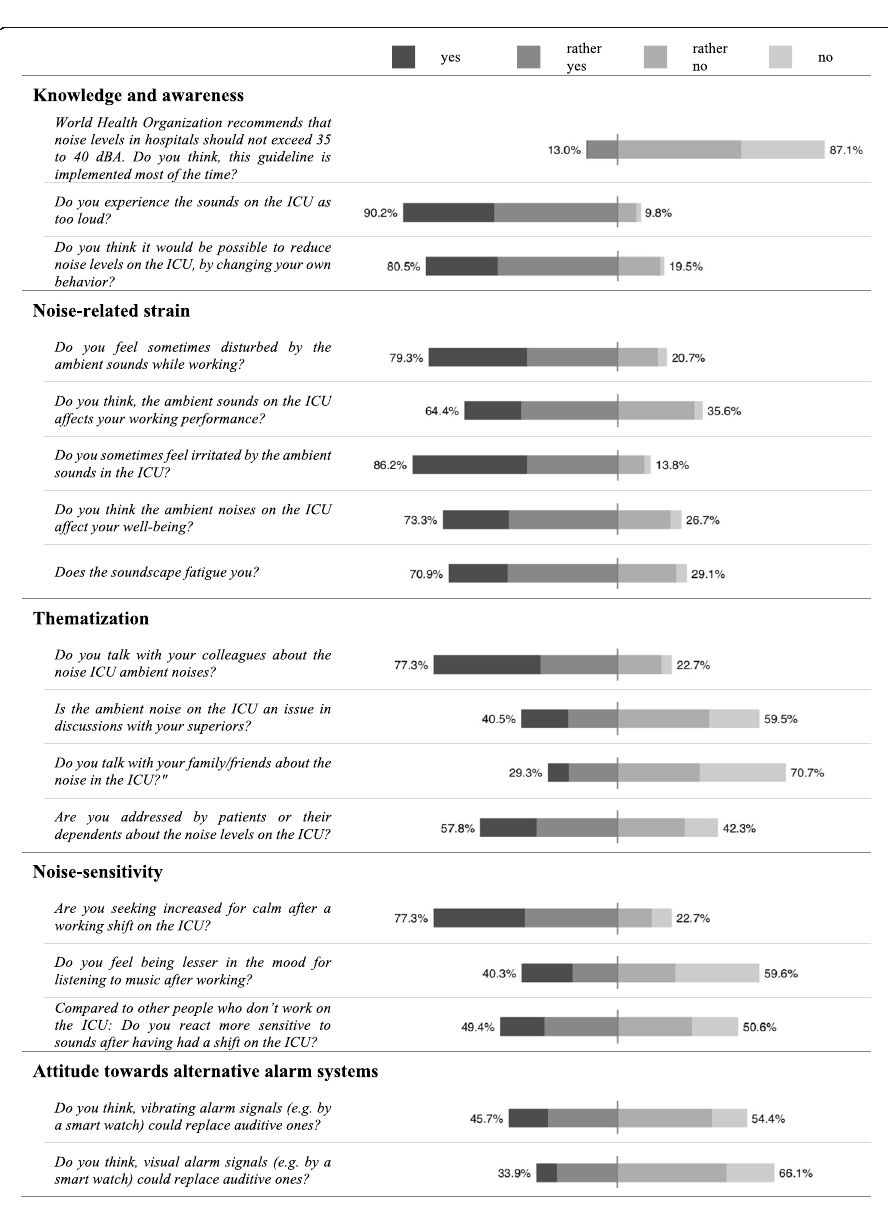
Fig. 2 Online survey results. Percentages of “ yes ” and “ rather yes ” compared to “ no ” and “ rather no ”